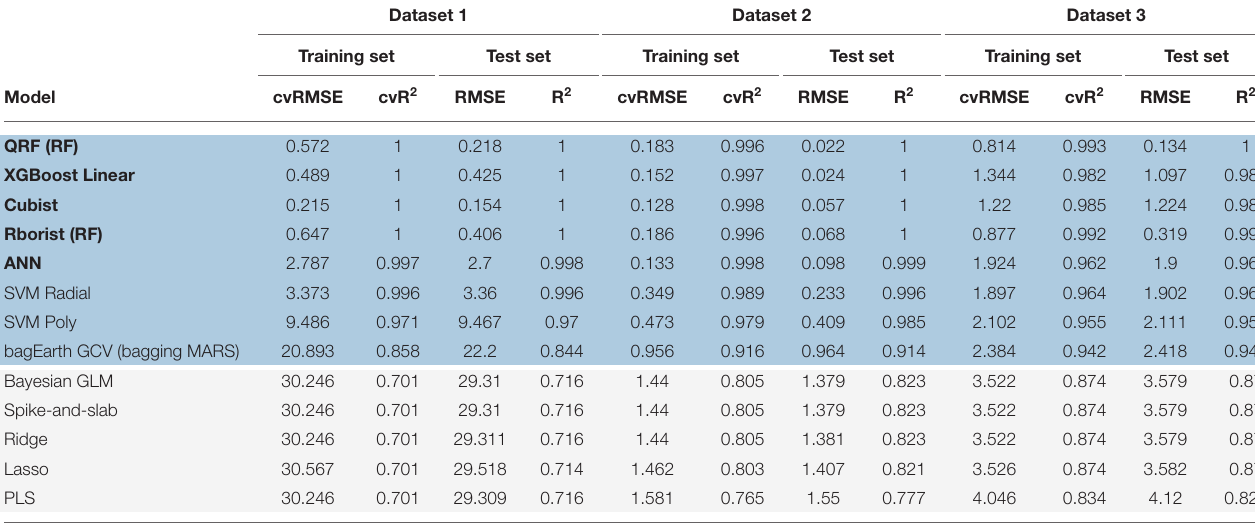
TABLE 3 | Summary table of statistical measurements for each predictive model.